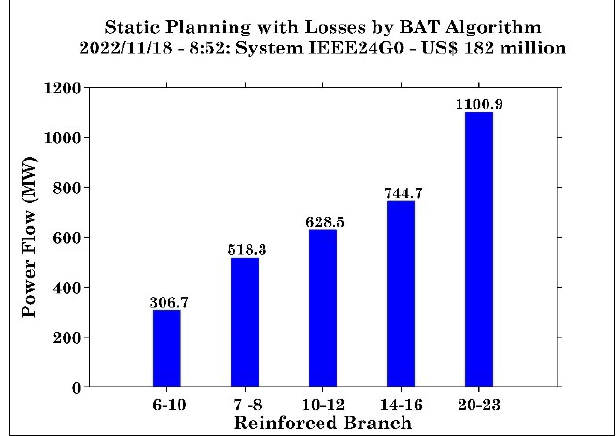
Figure 7: Case WR - IEEE-24/41 test system. Flows in the branches. Source: BATp optimizer, (2022).